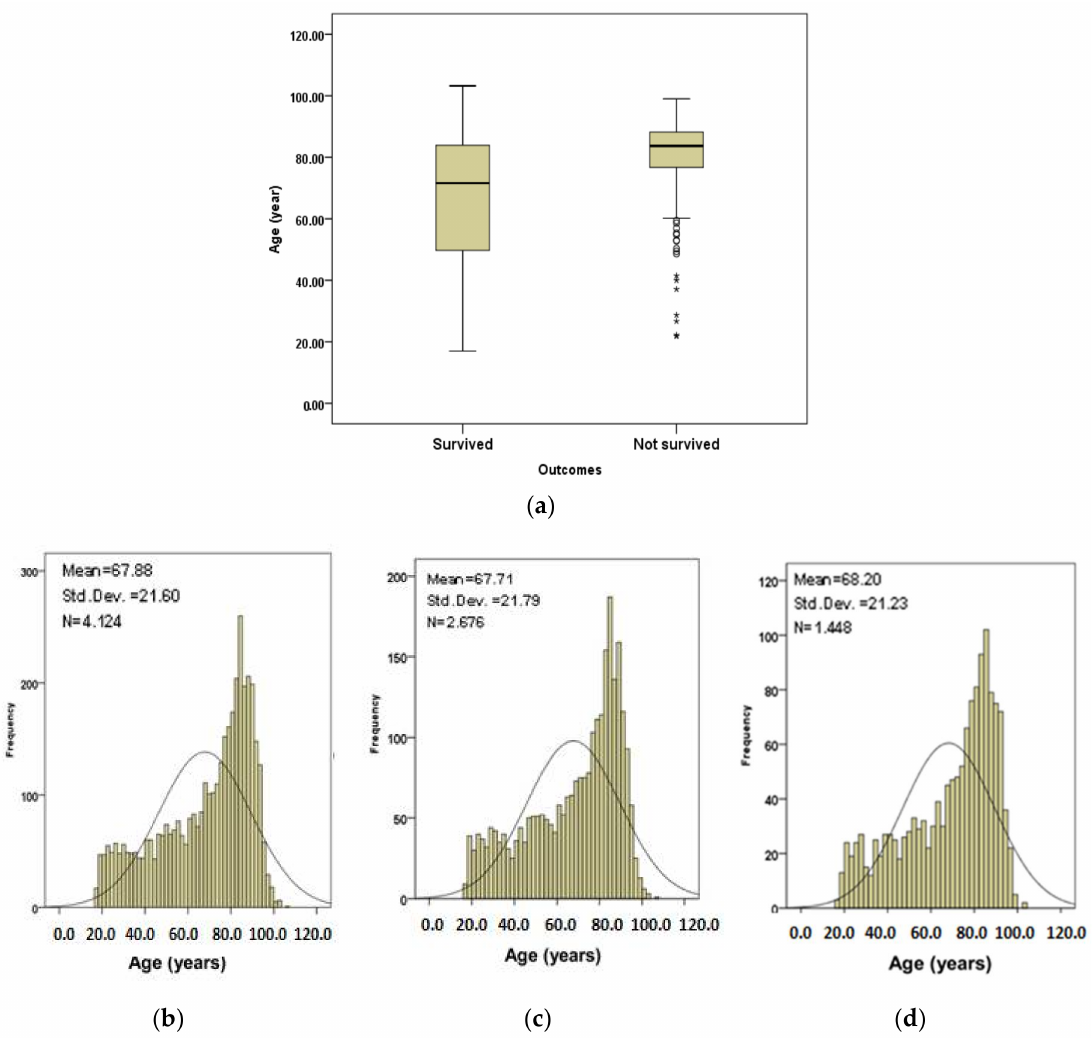
Figure 1. ( a ) Age boxplots for the subjects that survived and those that did not survive; ( b ) age distribution for all subjects; ( c ) age subjects of subjects in calibration set; ( d ) age distribution of subjects in validation set.